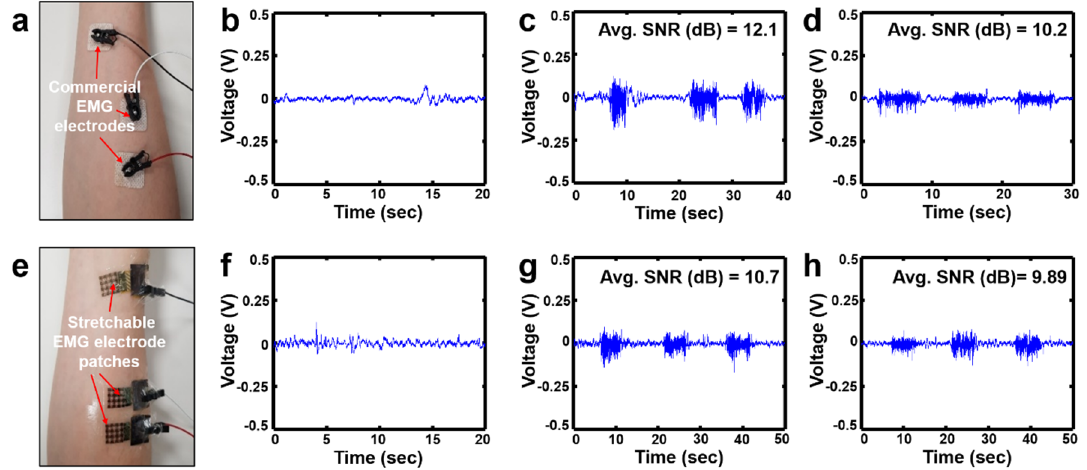
Figure 5. Results of in vivo EMG recording with the epidermal sensors and conventional sensors: ( a ) Commercial EMG sensors attached to a forearm; ( b ) Background signal of commercial sensors in standby state; ( c ) Activated EMG signals acquired by commercial sensors in clenching a fist motions; ( d ) Activated EMG signals acquired by commercial sensors in bending a wrist motions; ( e ) Epidermal EMG sensors attached to a forearm; ( f ) Background signal of epidermal sensors in standby state; ( g ) Activated EMG signals acquired by epidermal sensors in clenching a fist motions; ( h ) Activated EMG signals acquired by epidermal sensors in bending a wrist motions.